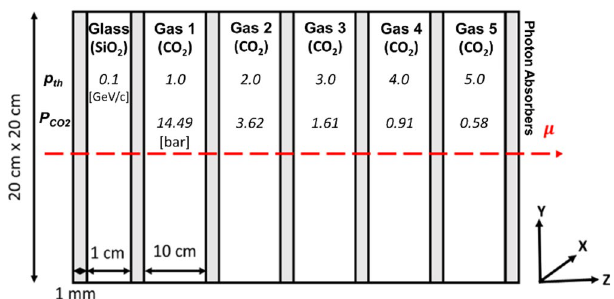
Figure 10. Overview of the Cherenkov muon spectrometer. It shows dimensions and materials of components. In addition, threshold momentum and CO 2 gas pressure of each radiator are also presented. Note: The figure is not proportional to the actual